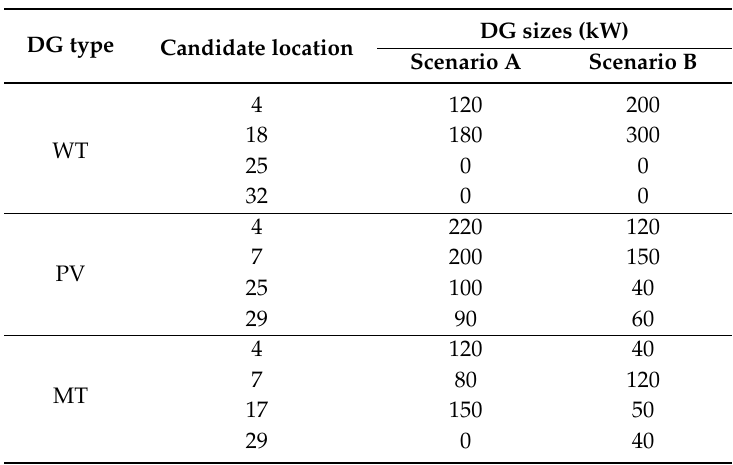
Table 7. Optimization results of different scenarios (33-bus system).